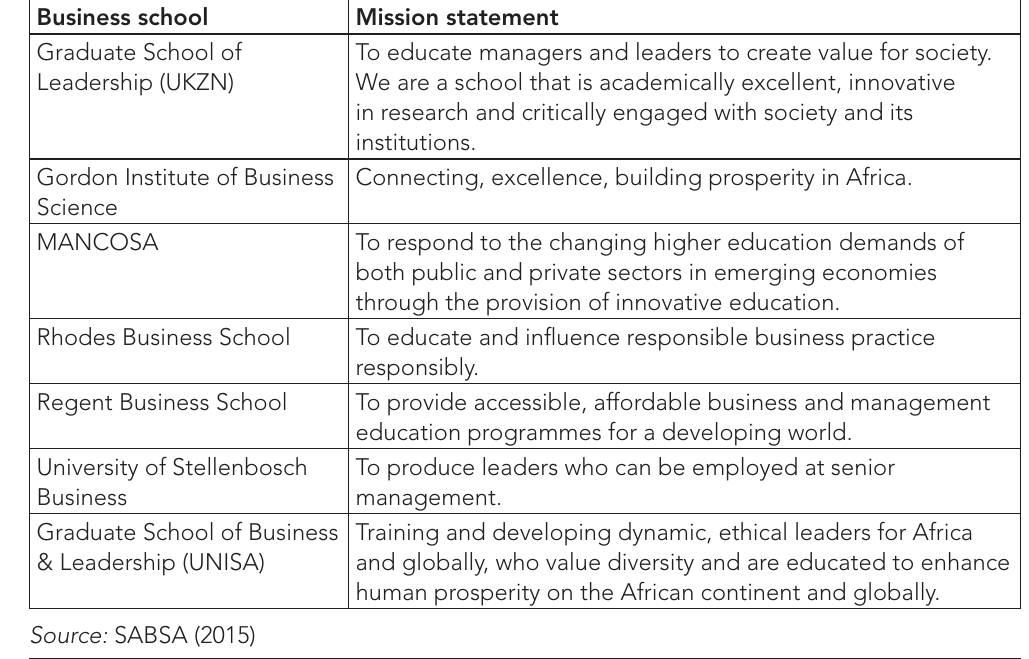
Table 1: Mission statements of selected MBA business schools in South